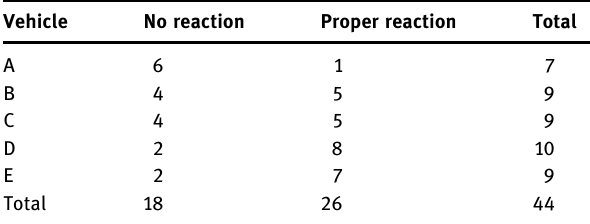
Table 3: System reactions in each